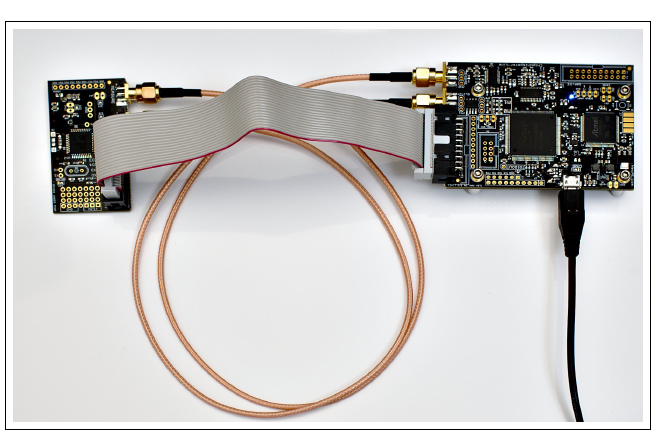
Figure 2: The ChipWhisperer-Lite evaluation board, connected to its XMEGA microcon- troller